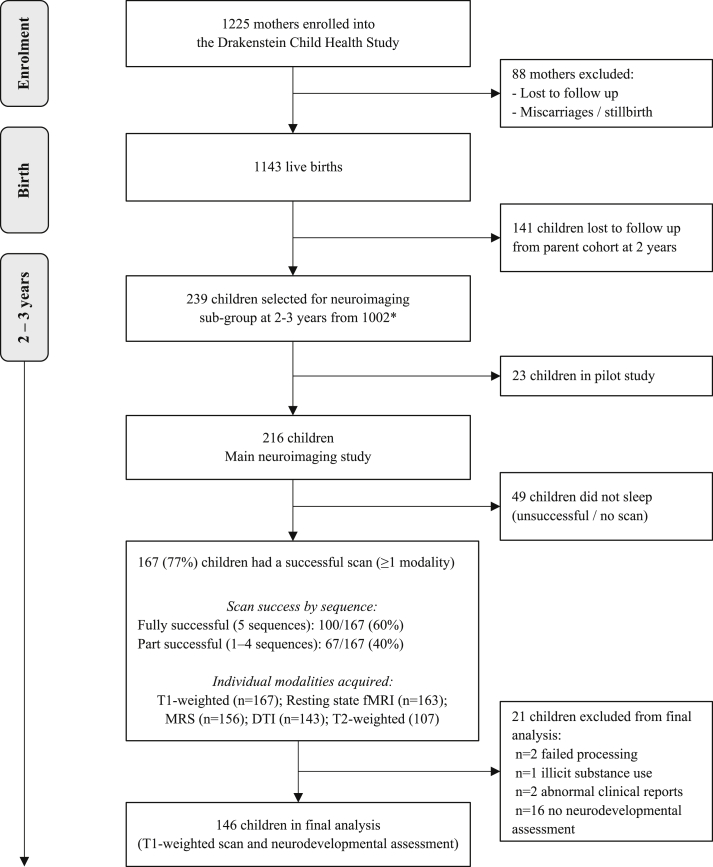
Flow chart for neuroimaging in the DCHS cohort and sequence success at 2–3 years.∗Selection criteria: Fully described in section 2.3.2. Inclusion criteria: Currently active in the cohort, staying in the study area, child aged 2–3 years. Exclusion criteria: (i) Medical comorbidity (genetic syndrome, neurological disorder, or congenital abnormality); (ii) Gestation <36 weeks; (iii) Low Apgar score (<7 ​at 5 ​min); (iv) Neonatal intensive care admission; (v) Maternal use of illicit drugs during pregnancy; (vi) Child HIV infection.